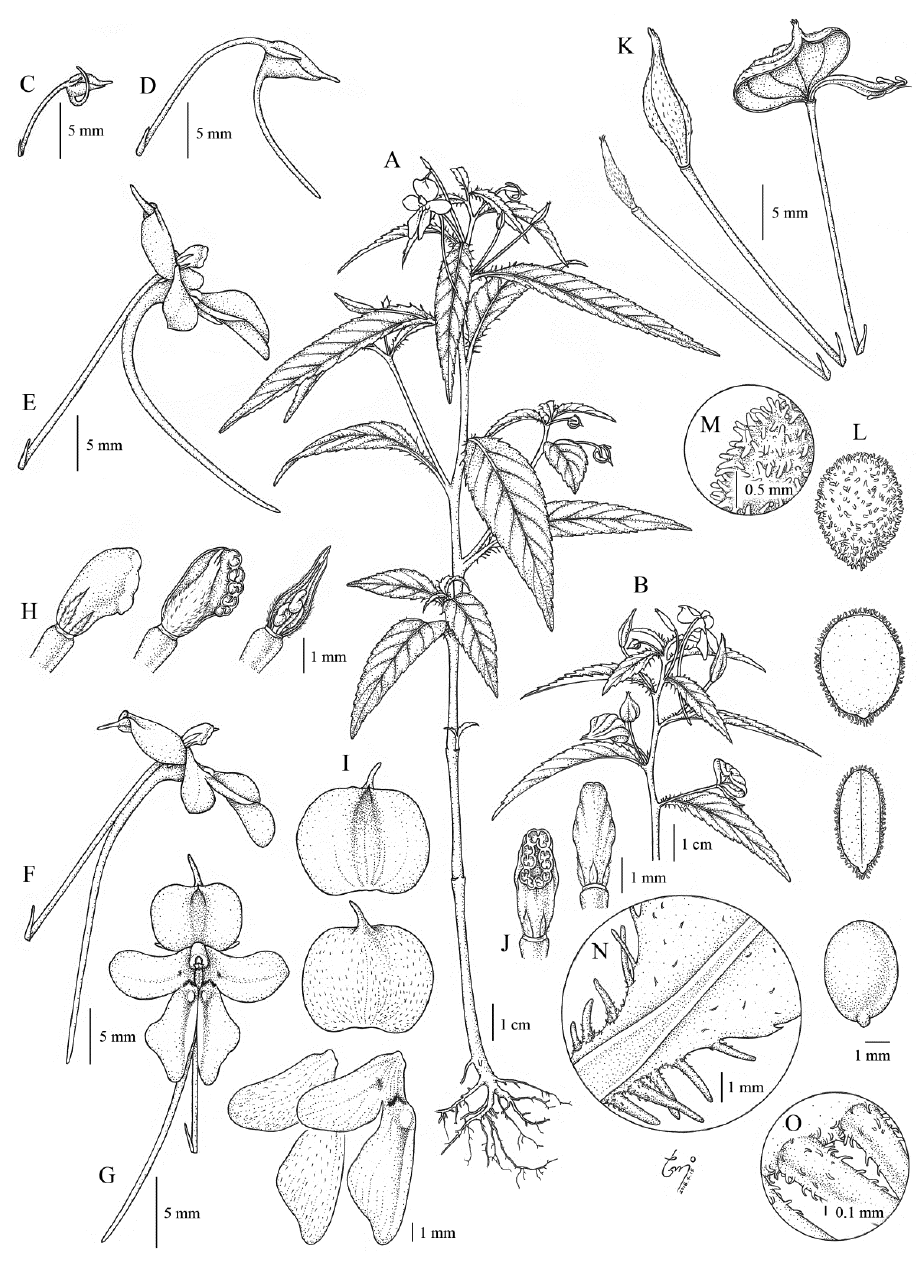
Figure 1. Impatiens bokorensis A Flowering individual B Fruiting individual C–D Developing flower bud E Mature flower (before pollination) F–G Mature flower (after pollination) H Developing gynoe- cium I Petals J Androecium K Developing fruit L–M Seed N–O strigose-ciliate at leaf base: Cho et al. CB-3112, 3432. Illustration by Hye-Woo